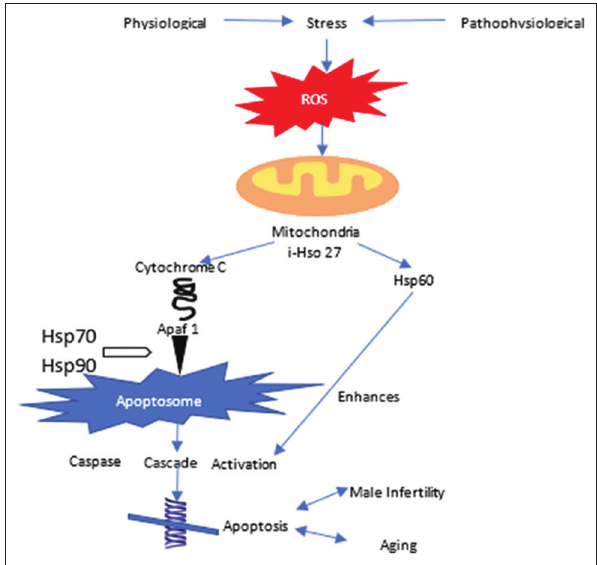
Figure-2: Involvement of heat shock proteins in human aging and fertility.